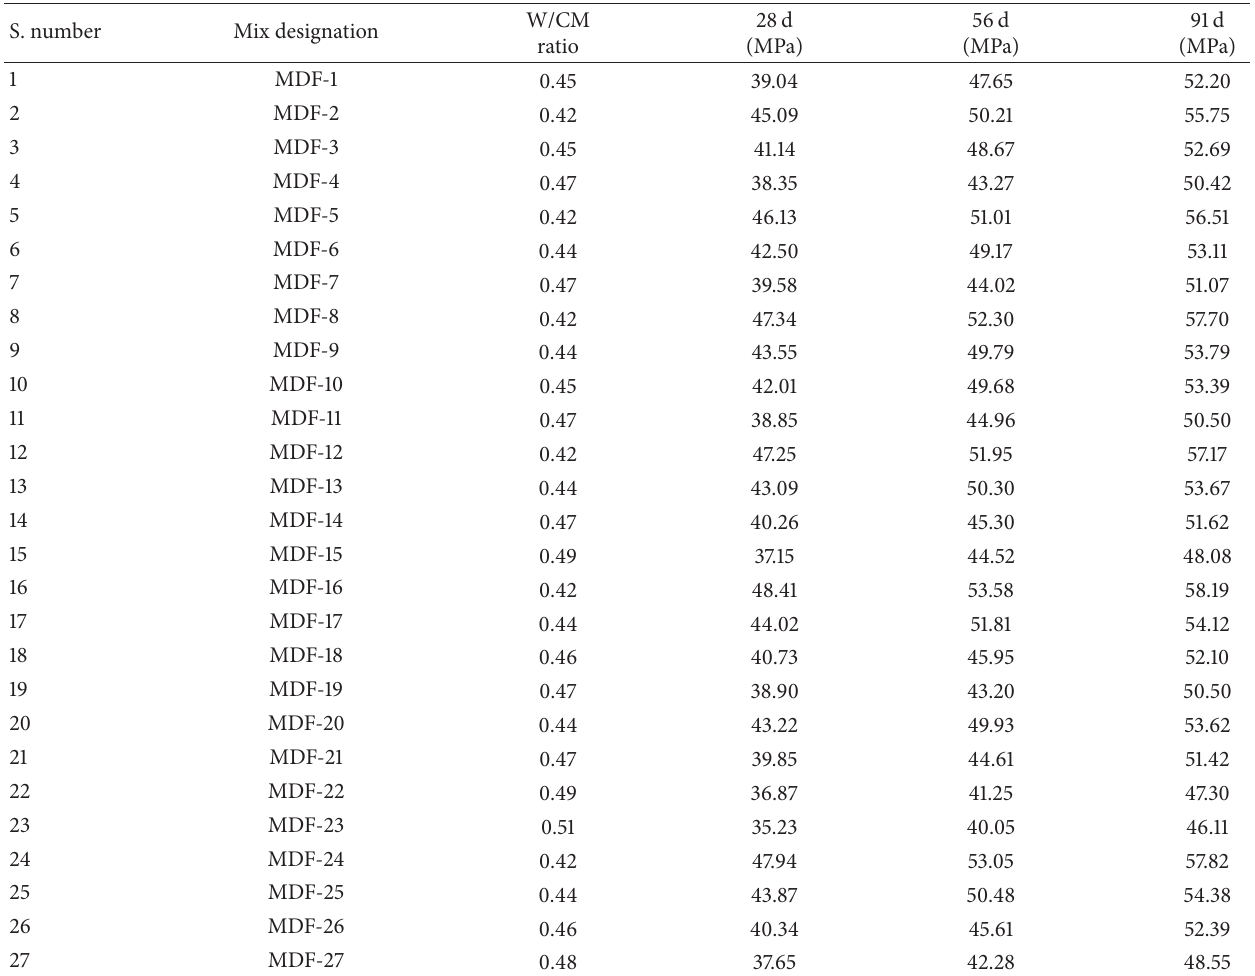
Table 4: Details of compressive strength of concrete mixes with fly ash after curing of 28, 56, and 91 days. S.